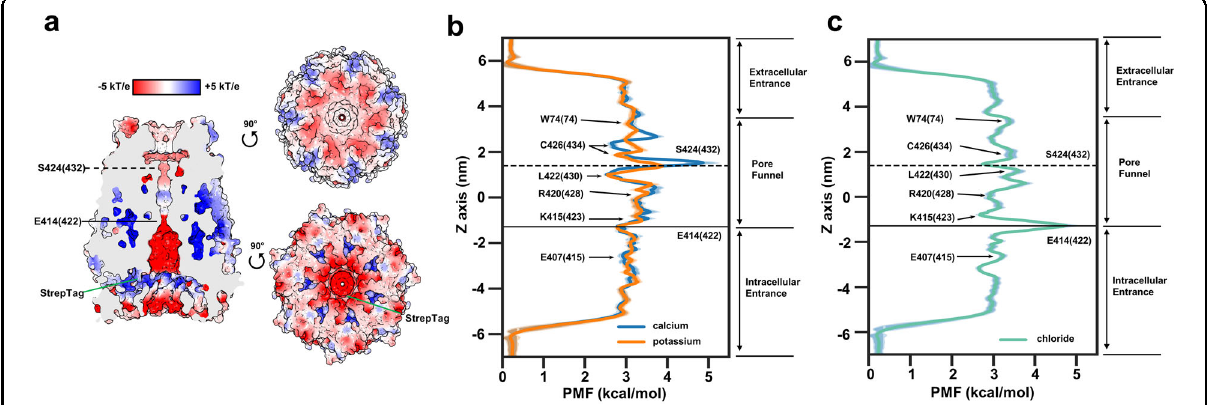
Fig. 4 Energetics of ion permeation analysis of key residues in hPANX1 structure. a Surface representation of the full-length hPANX1-MD structure colored by coulombic potential (red, negative; white, neutral; blue, positive). Cross-section is colored in gray. T temperature, k Boltzmann constant, e charge of an electron. Location of Strep-tag (residue 173 – 180) is indicated by a green pointer. b Potential of mean force (PMF) pro fi le describing the free-energy landscape in kcal/mol experienced by positive (potassium K + , orange trace; calcium Ca 2 + , blue trace) ions permeating the channel pore. Amino acid positions are indicated with arrows. E414(422) and S424(432) are marked on Z -axis as solid and dashed lines respectively. c Potential of mean force PMF pro fi le describing the free-energy landscape in kcal/mol experienced by negative (chloride Cl − , green trace) ions permeating the channel pore. Amino acid positions are indicated with arrows. E414(422) and S424(432) are marked on Z -axis as solid and dashed lines